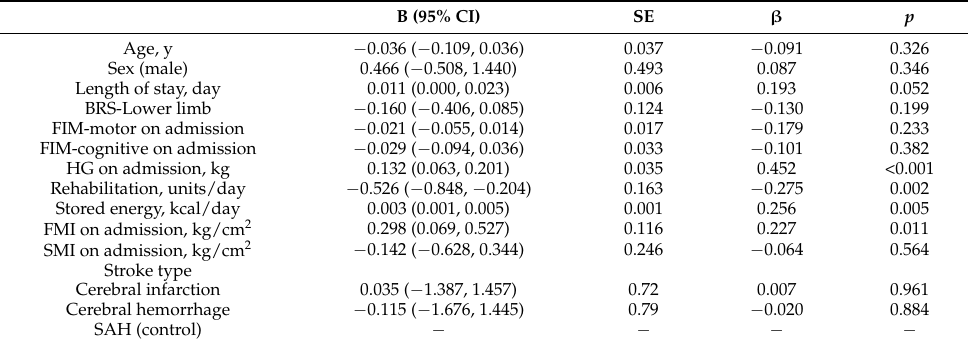
Table 3. Multivariate regression analysis for BW gain during